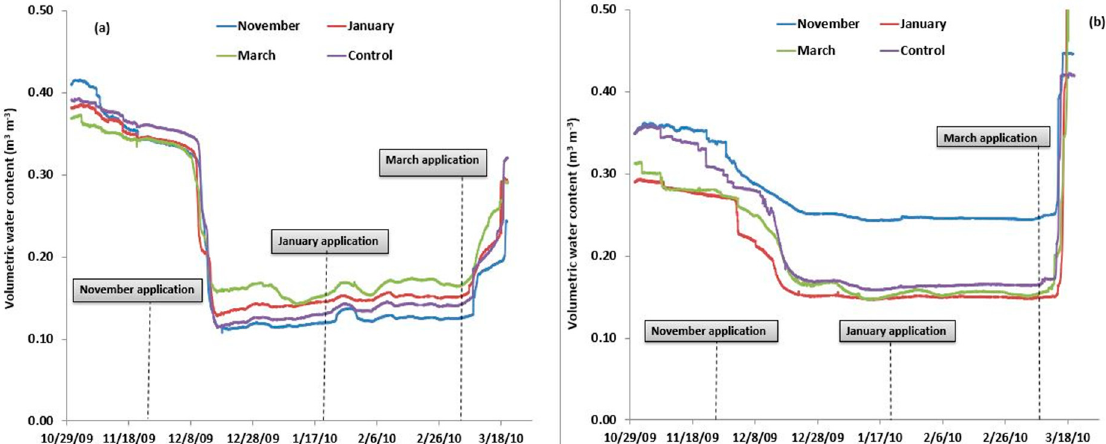
Figure 4. Soil volumetric water content (VWC) at ( a ) 15 cm, and ( b ) 51 cm soil depth for manure timing treatments (mean overall manure treatments); Brookings, SD.